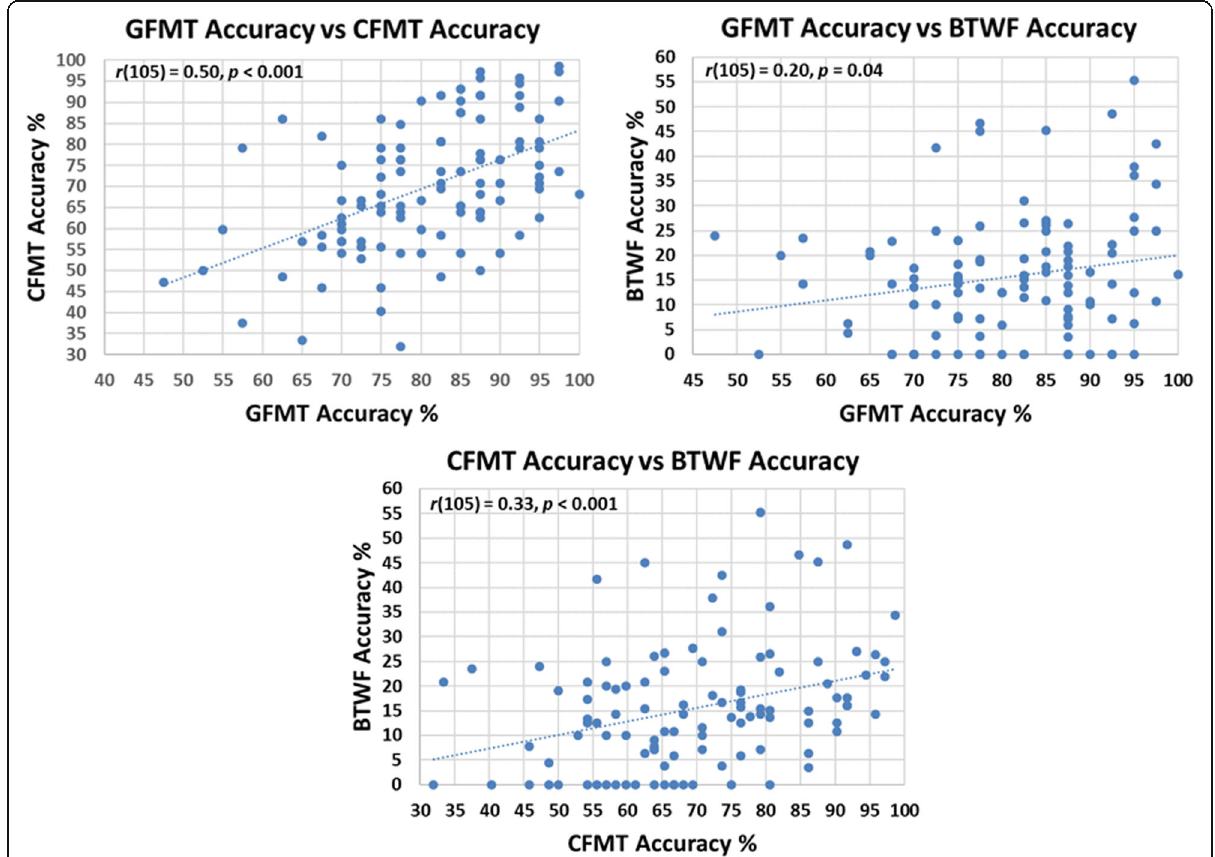
Fig. 3 Scatterplots showing the correlations between performance on the three core face tests in Study